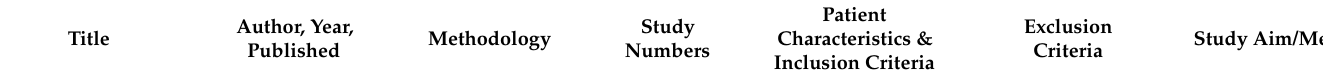
Table 1. Studies describing urinary metabolites in preterm infants